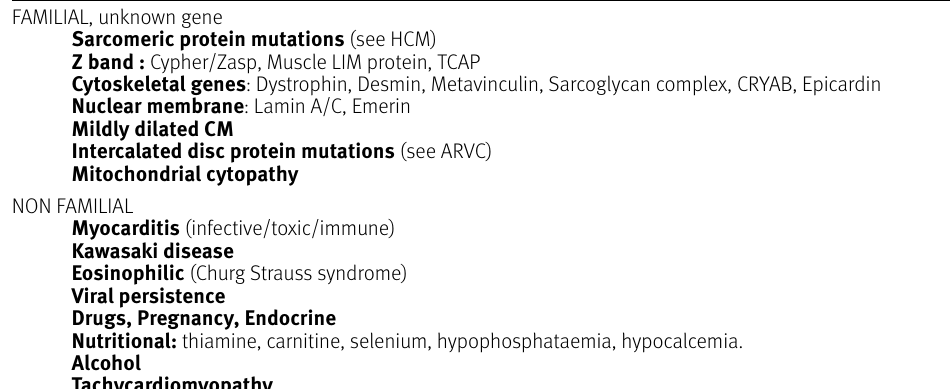
Table 2. Dilated